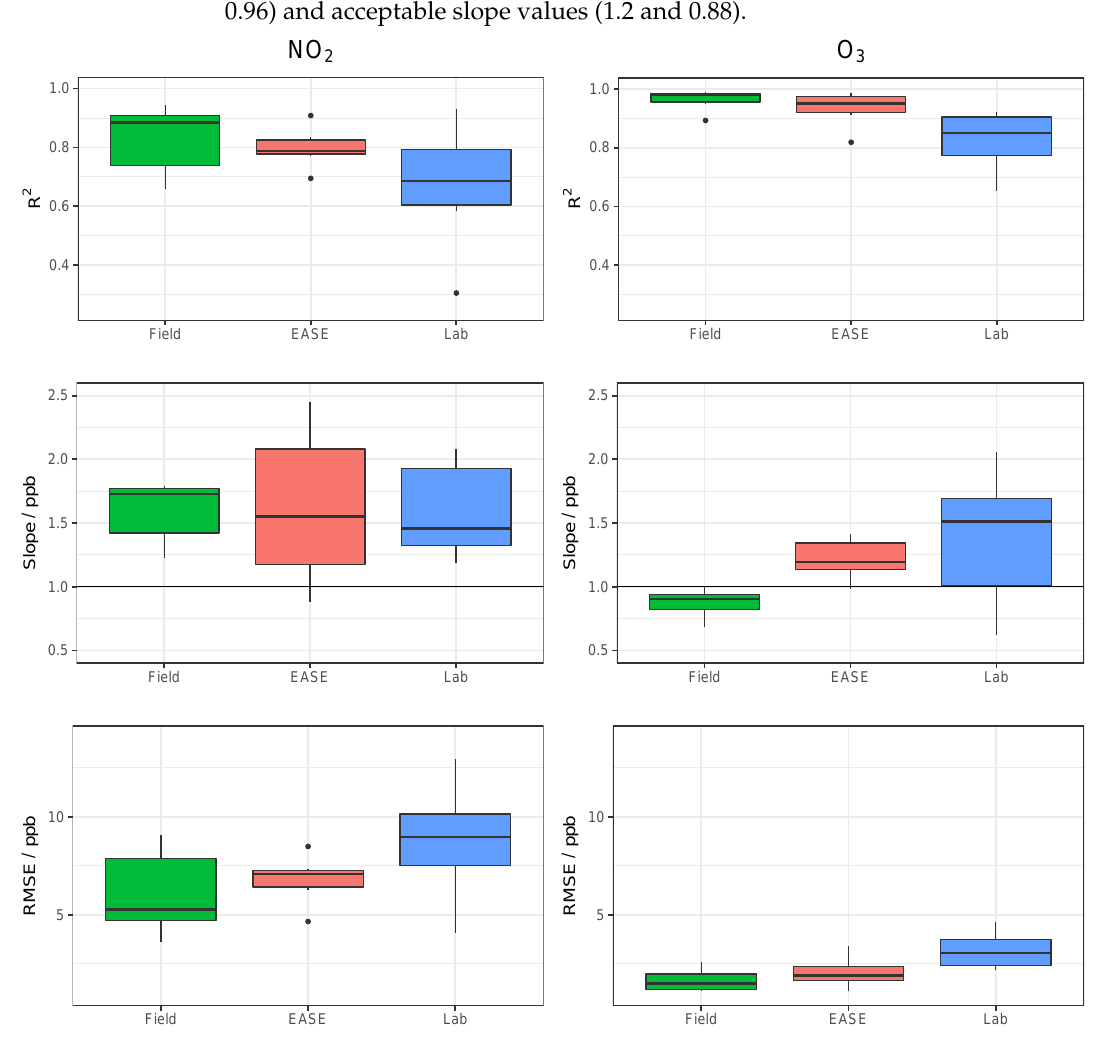
Figure 11. Comparison of R 2 , slope, and RMSE for calibration model validation of MOx sensors with the different methods for both NO 2 ( left ) and O 3 ( right ). Lab is short for